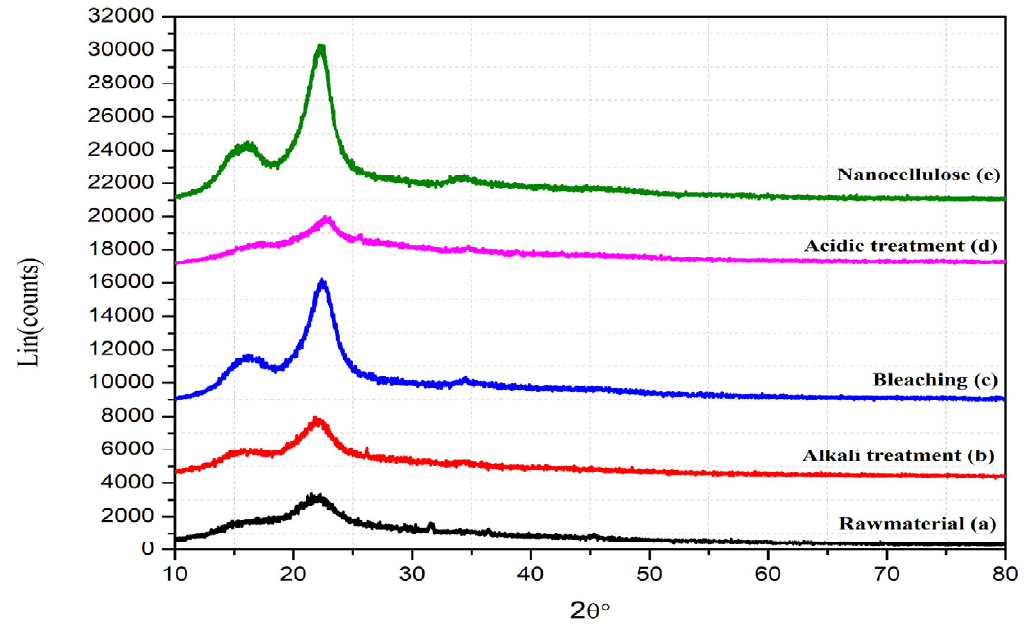
Fig. 5. The XRD pattern of a processed sample Table 3. CrI value of cotton straw Sample